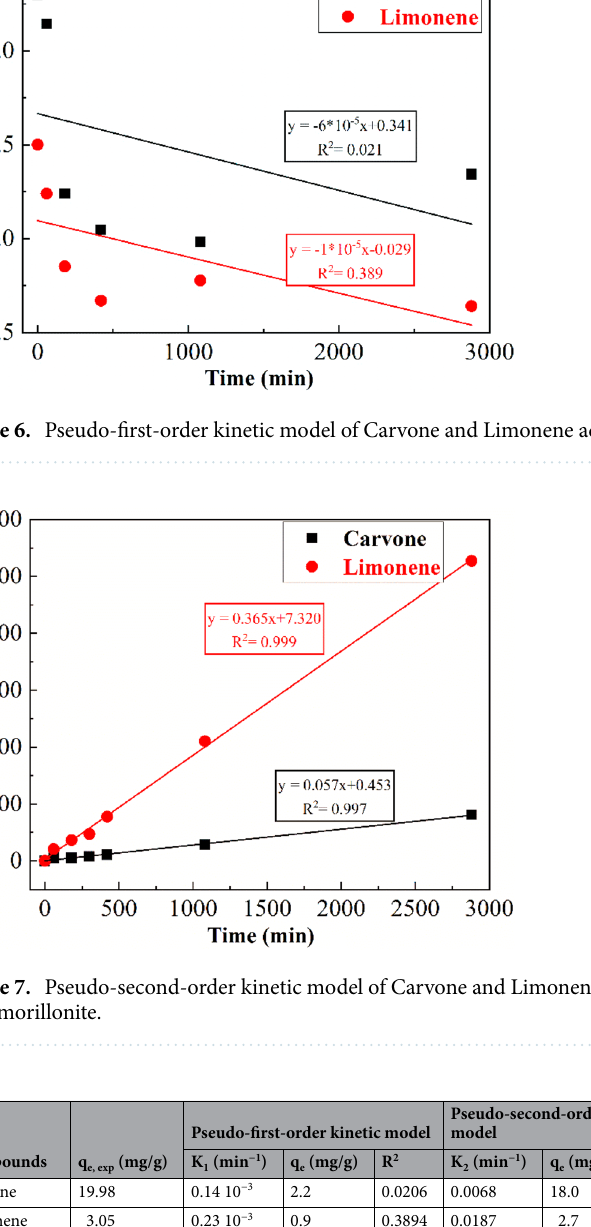
Compounds q e, exp (mg/g)